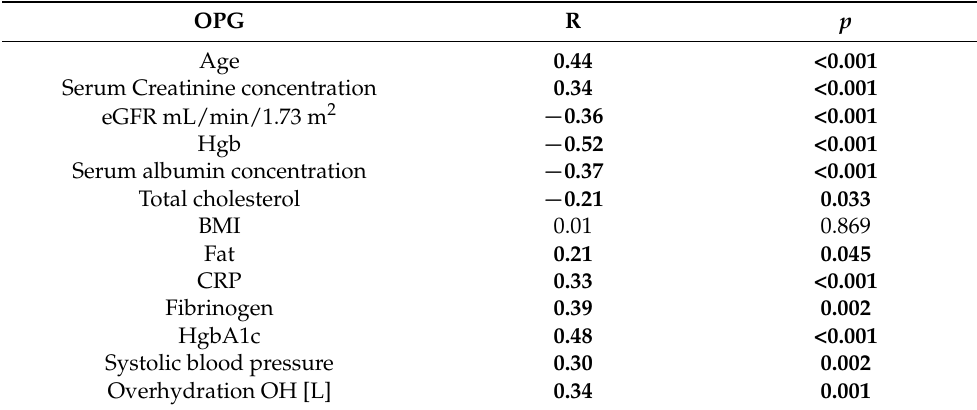
Table 2. Correlations between OPG and the studied parameters.